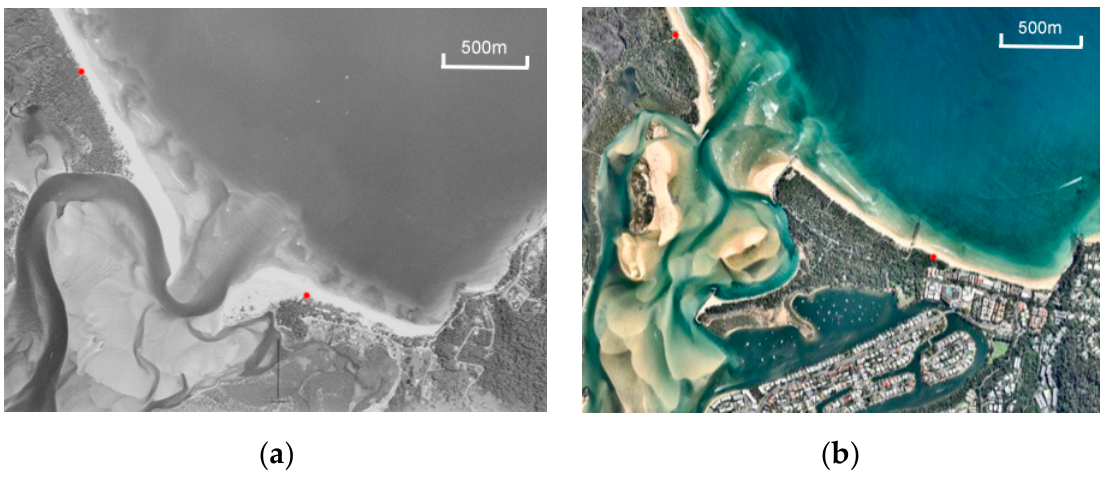
Figure 2. Comparison of Noosa Main Beach, May 1958 ( a ) to March 2019 ( b ). Two location markers (red points) have been added on each photo for comparison. Note the relocation of the river, narrowed beach and two prominent groynes. Source: QImagery ( a ) and Nearmap.com.au ( b ).